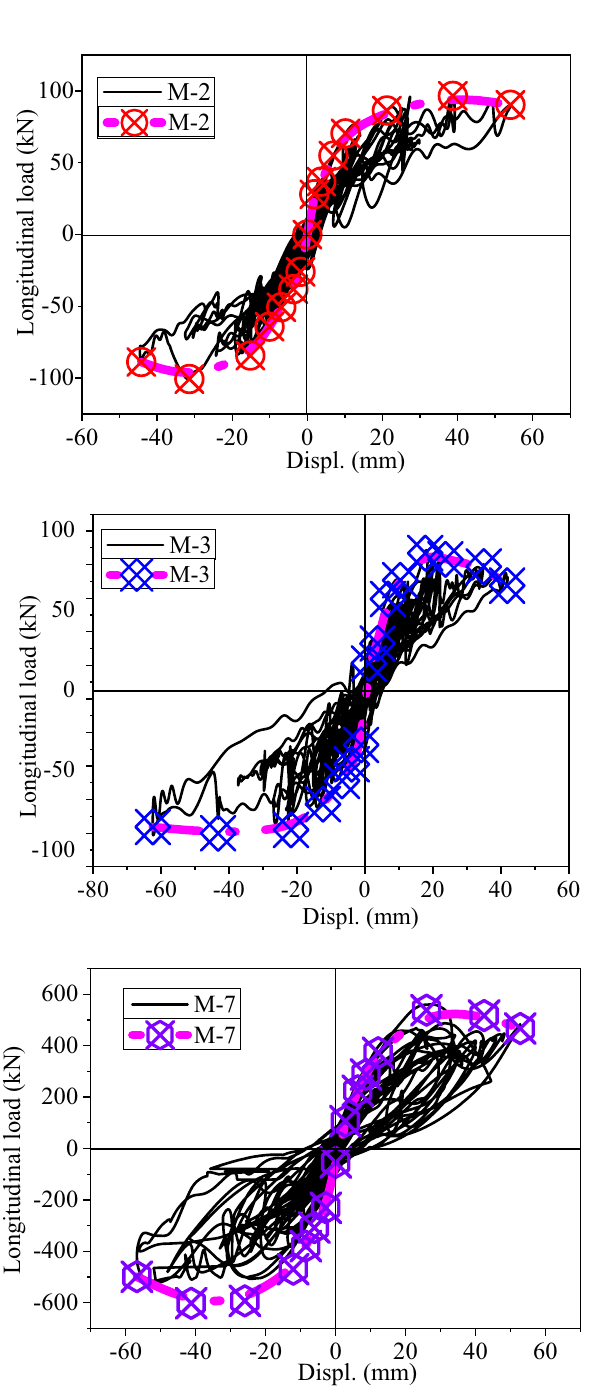
Figure 17. Load–displacement hysteresis curves for bridge pier model in the longitudinal